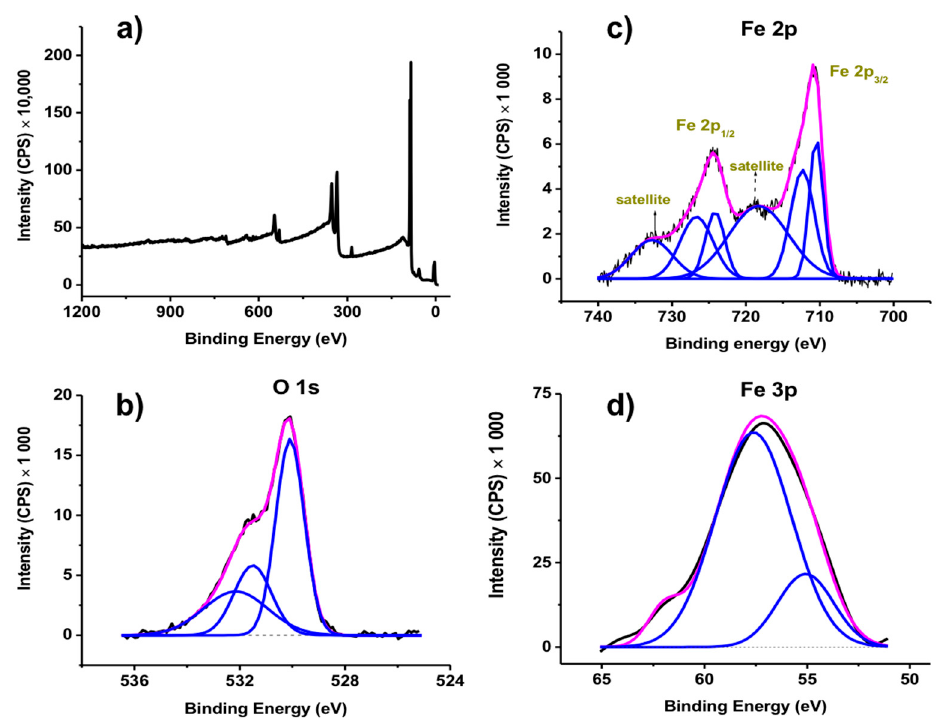
Figure 4. XPS spectra of γ -Fe 2 O 3 MNPs: ( a ) survey (deconvoluted) and ( b ) O 1s, ( c ) Fe 2p and ( d ) Fe 3p core level spectra.